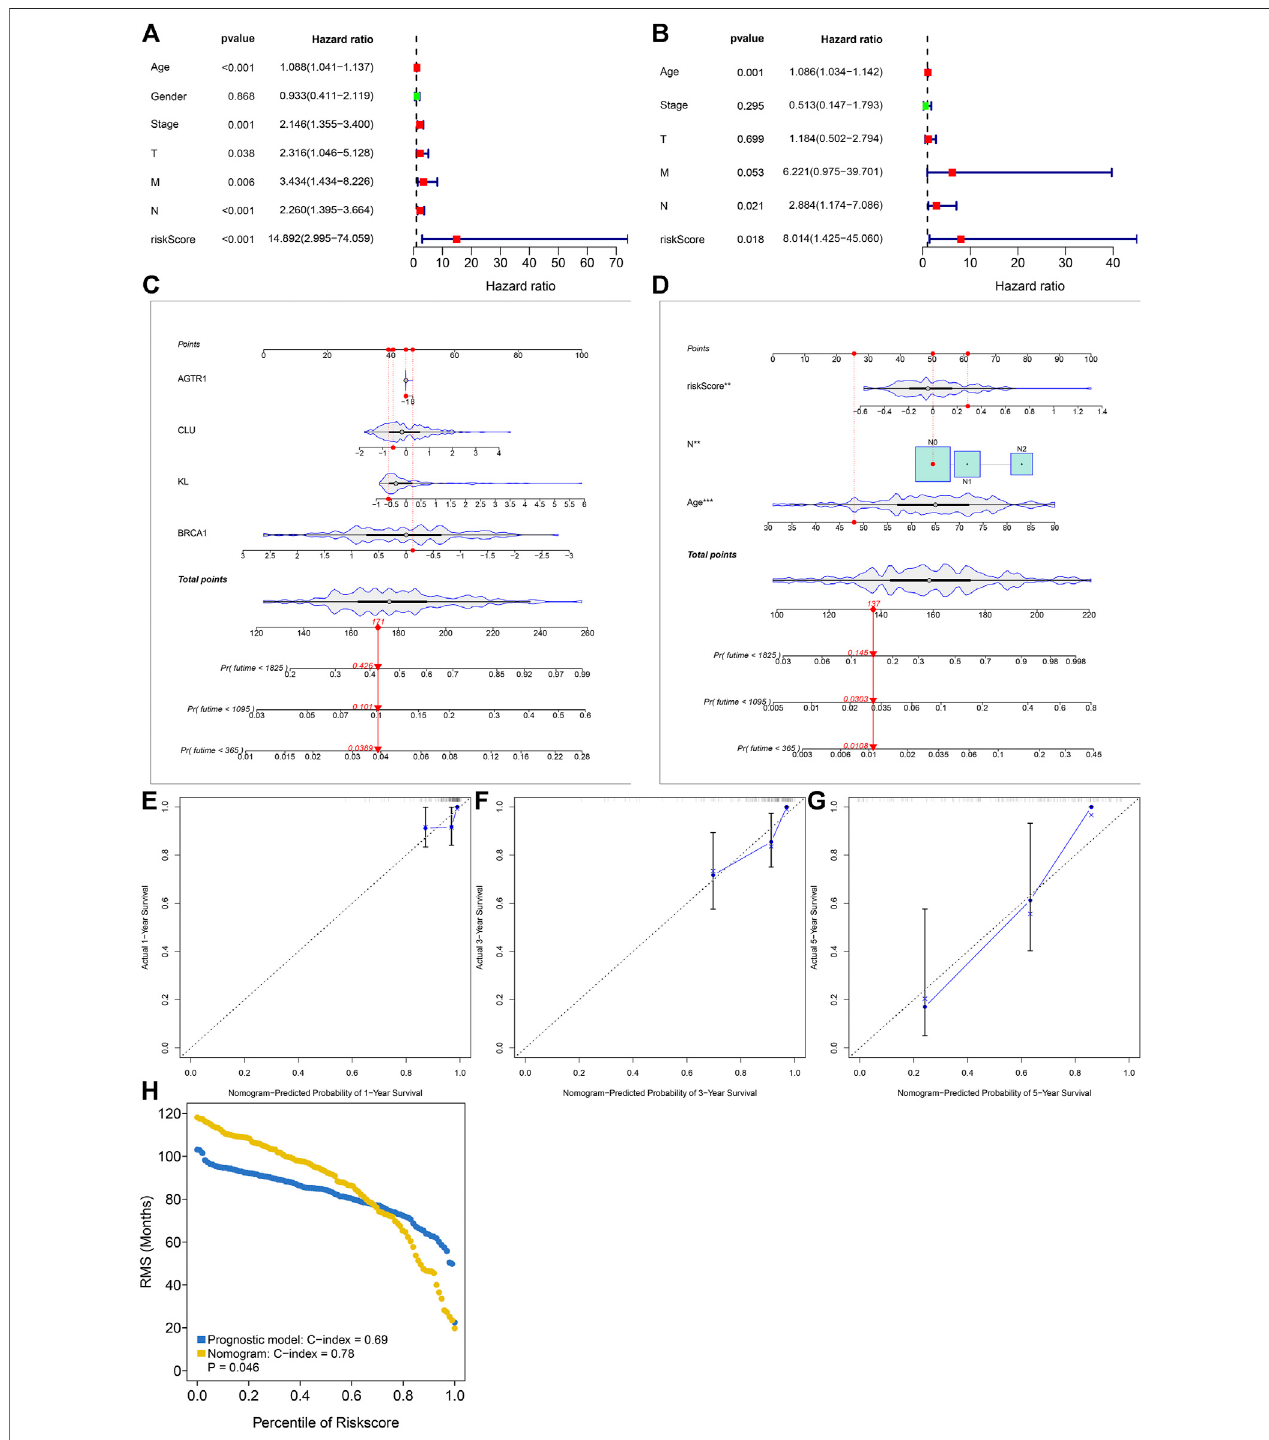
FIGURE 3 | Aging-related gene model as an independent risk factor of rectal cancer in the discovery set. (A, B) Uni- and multivariate Cox regression models for investigating the associations of the aging-related gene model and conventional clinical factors with rectal cancer prognosis. (C) The prognostic nomogram containing KL, BRCA1, CLU, and AGTR1. (D) The prognostic nomogram that includes independent risk factors. (E – G) Calibration curves for the associations between actual and nomogram-estimated probabilities of 1-, 3- and 5-year survival. (H) The C-index values of the aging-related gene model and the prognostic nomogram.